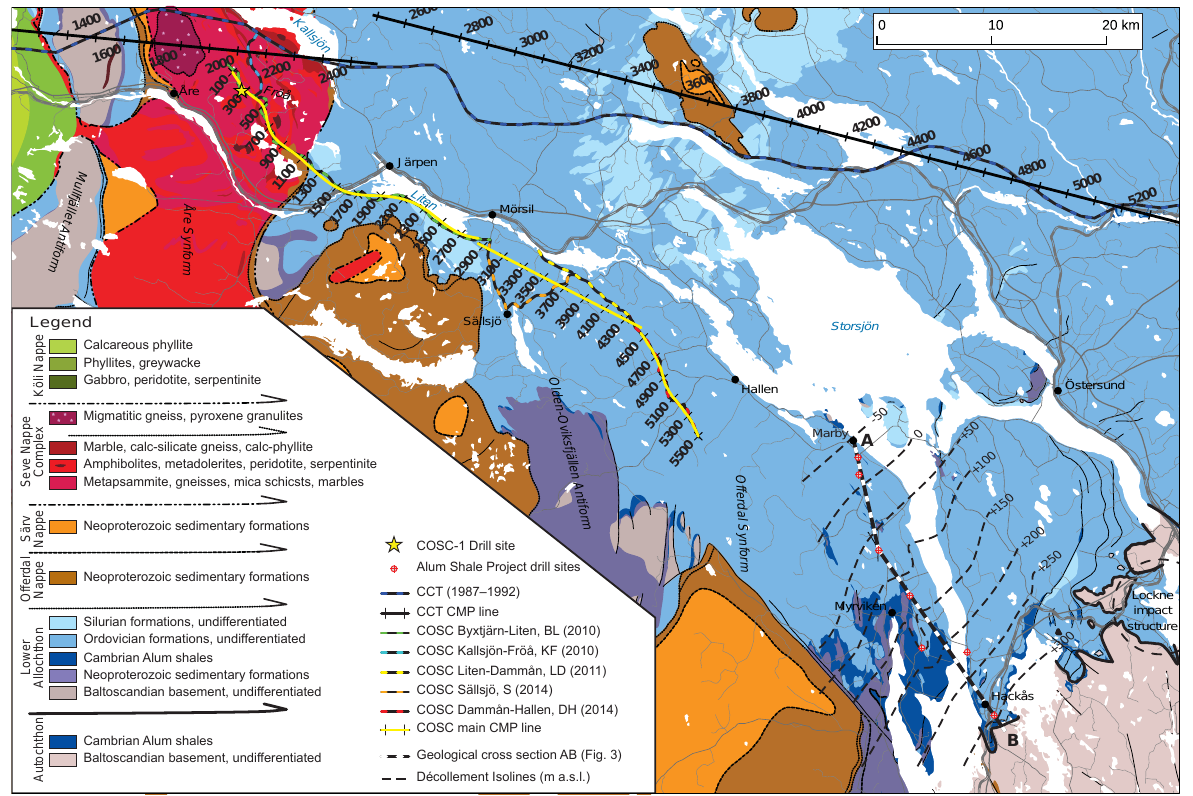
Figure 2. Bedrock geological map of western Jämtland, based on the bedrock geological map of Sweden, © Geological Survey of Sweden [I2014/00601] and Strömberg et al. (1984), showing the locations of the CSP and CCT seismic profiles, the COSC-1 borehole, and the shallow drill holes in the Myrviken area. The location of the geological cross section, shown in Fig. 3, is also